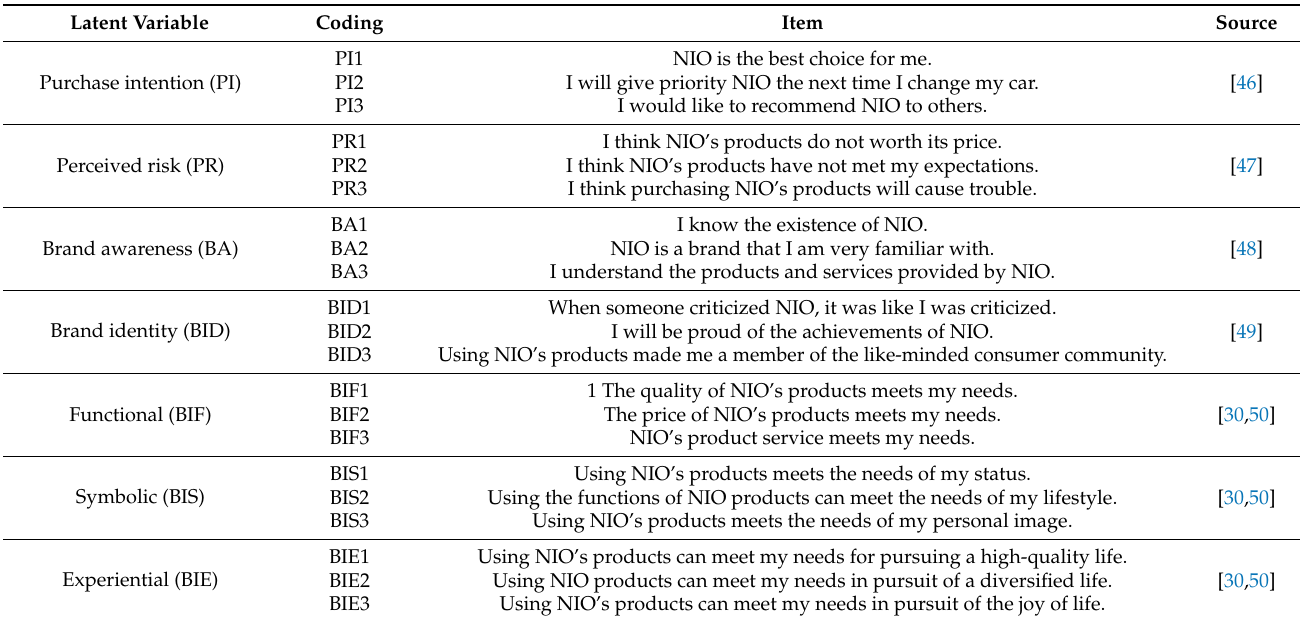
Table 1. Measurement scale.